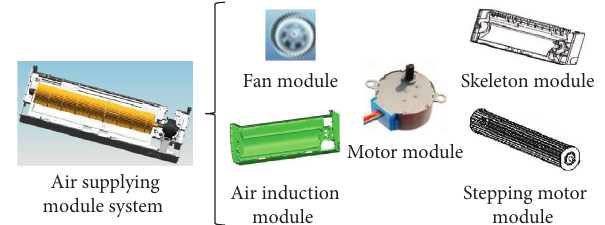
Figure 5: Composition of the air-supplying module system of